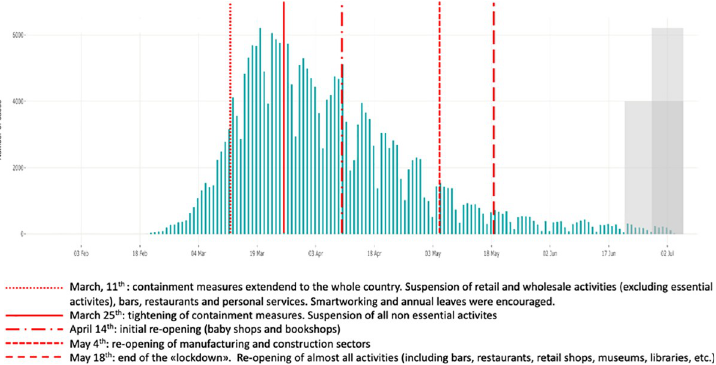
Fig 2. Epidemiological trend and major lockdown/re-opening measures. Adapted from [8]. Note: more recent data (grey square) should be interpreted with caution due to the possible reporting delay of more recently diagnosed cases and to the possibility that cases with data of onset within the reporting period have not yet been